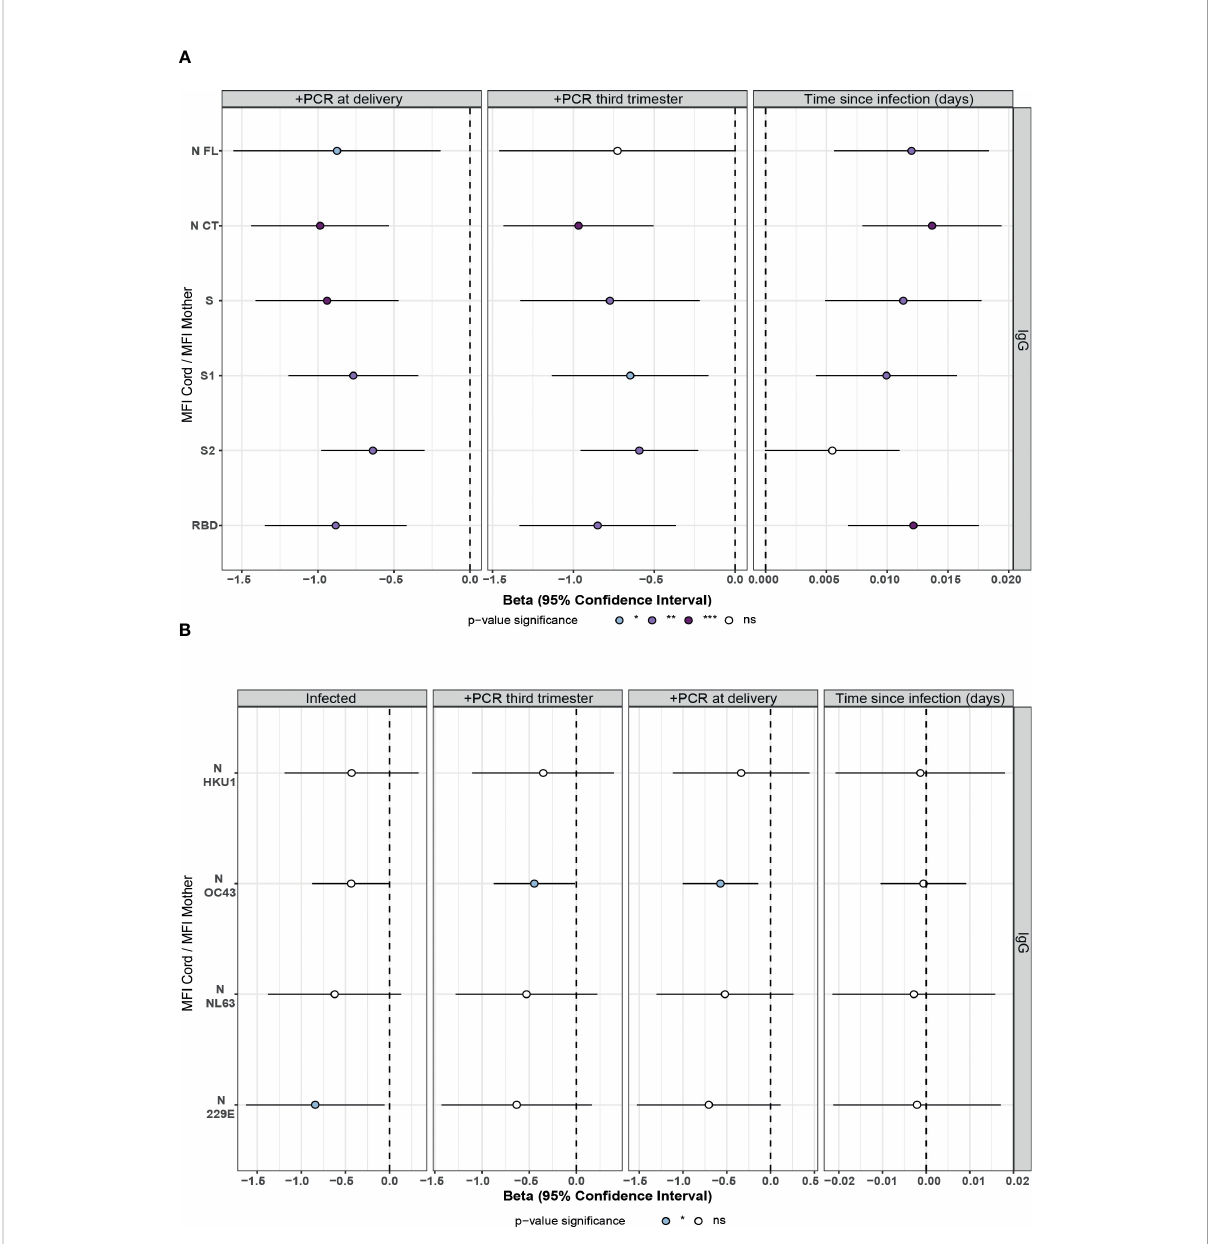
FIGURE 4 Association of SARS-CoV-2 infection and time since infection on IgG transfer from mother to the newborn in univariable linear regression models. Forest plots show the effect of SARS-CoV-2 infection, positive rRT-PCR (+PCR) during the third trimester or at delivery, and the time since infection (days since positive rRT-PCR or symptoms onset) on IgG transfer from mother to the newborn (MFI Cord/MFI Mother) for (A) SARS-CoV-2 antigens in seropositive paired infected mothers and cord blood and (B) HuCoVs N proteins in all study population. Univariable linear regression models were fi tted to calculate the betas (dots) and 95% con fi dence intervals (CI) (lines). The color of the dots represents the p-value signi fi cance, where *p-value ≤ 0.05, **p-value ≤ 0.01 and ***p-value ≤ 0.001, ns, not signi fi cant. Antigens: nucleocapsid full-length (N FL) and C-terminus (N CT), spike full-length (S), S1 and S2 subunits, and receptor-binding domain